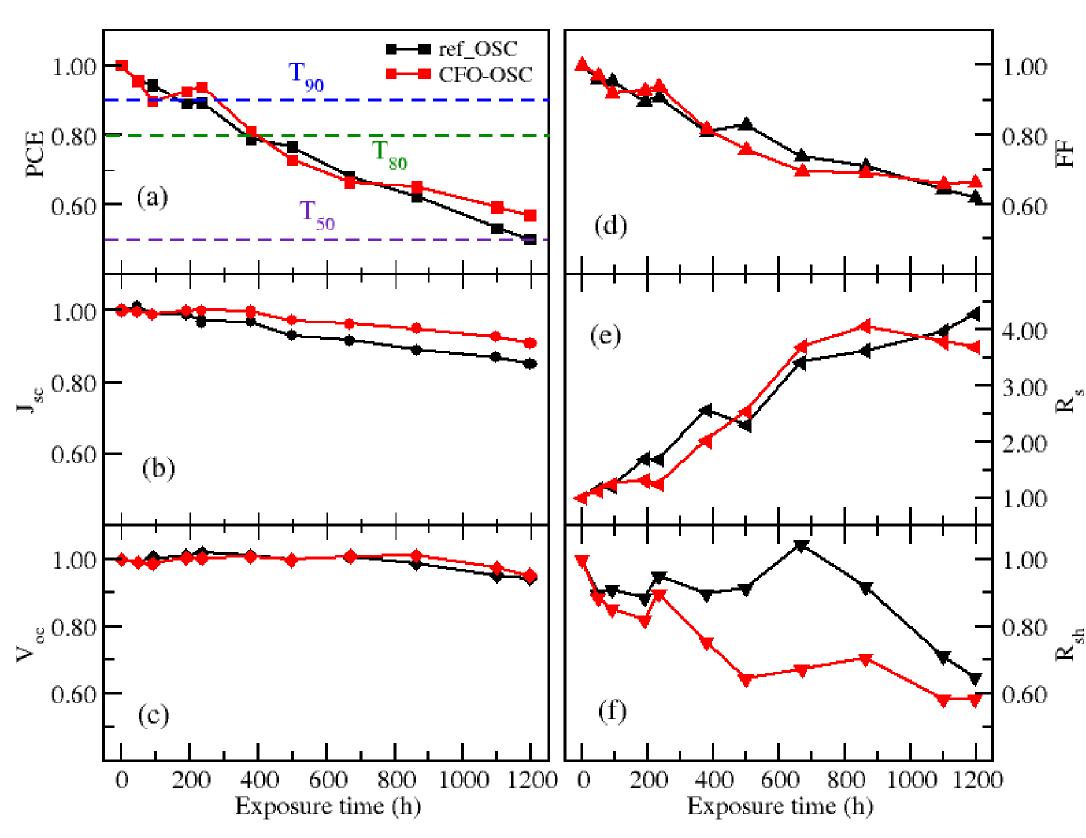
, (c) V , (d) FF, (e) R and (f) R of ref-OSC (black) and CFO-OSC (red) sc oc s sh